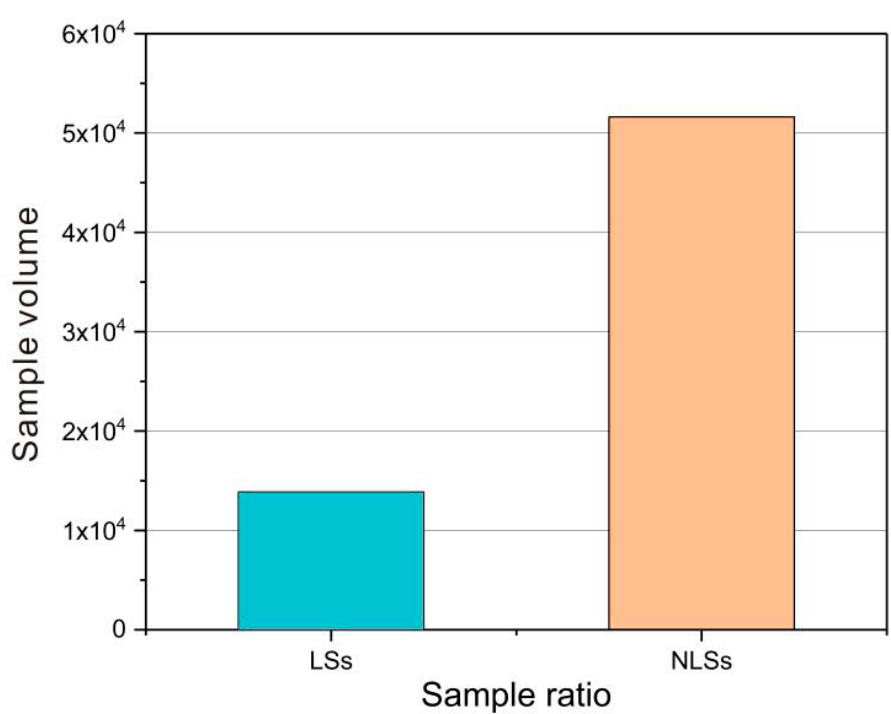
Figure 6. Sample ratio for LSs (landslides) and NLSs (non-landslides). Data